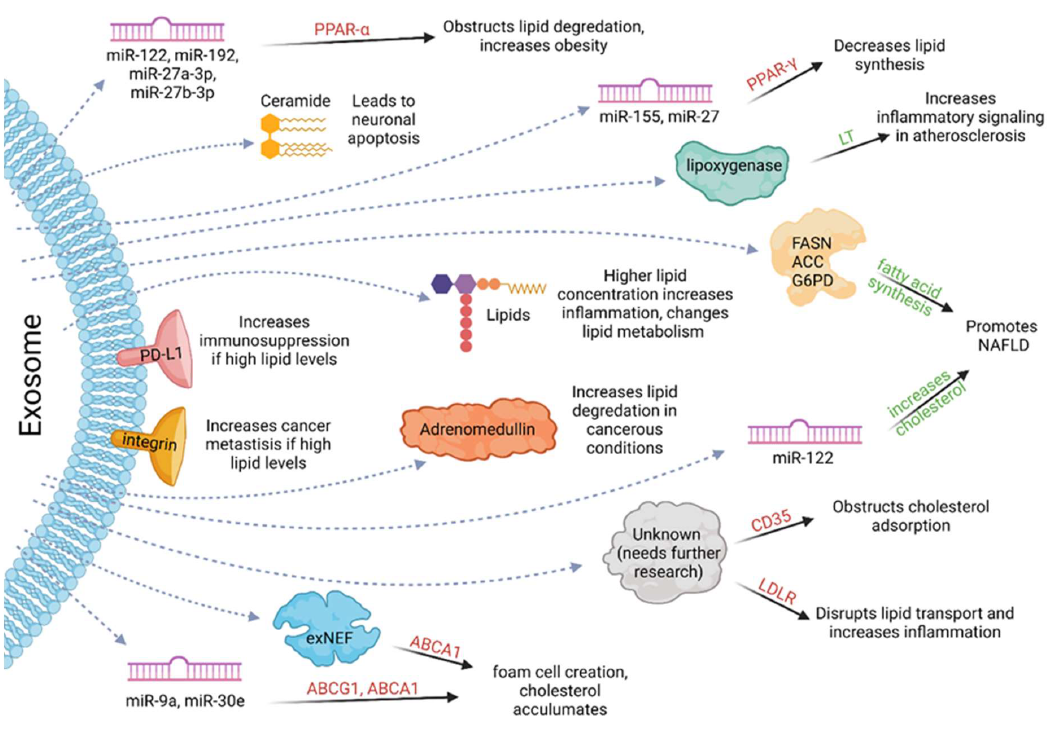
Figure 2. Effect of exosomal cargo on lipid metabolism. Exosomal cargo alters various types of lipid metabolism, such as lipid synthesis, degradation, and transport, which play crucial roles in regulating lipid-mediated diseases. Red text indicates that these molecules/pathways are down-regulated by the exosomal cargo, and green text indicates that these molecules/processes are up-regulated by the cargo. Figure created with BioRender.